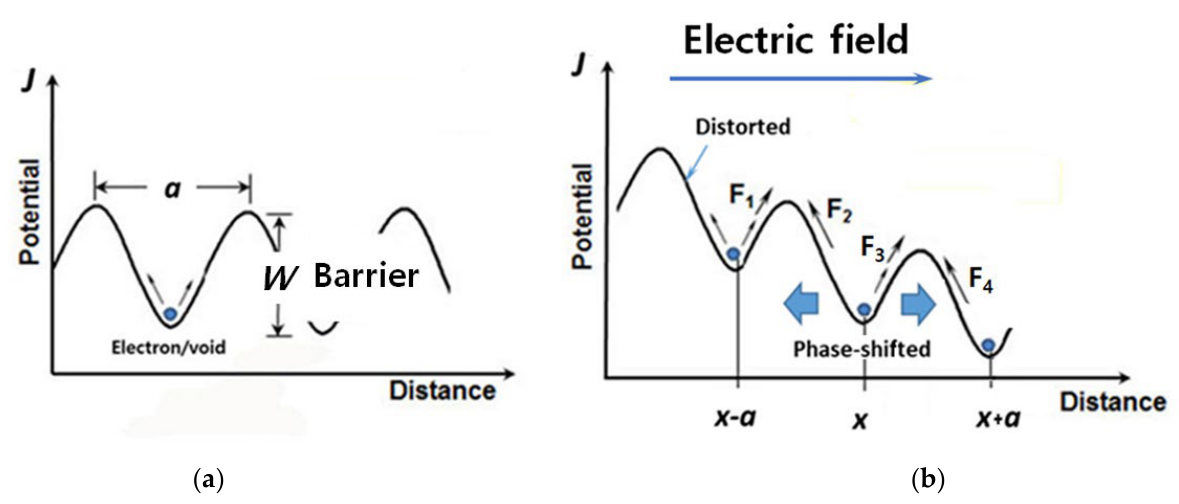
Figure 5. Potential variation in material—silicon—when electromagnetic field is applied: ( a ) initial stage; ( b ) final stage.